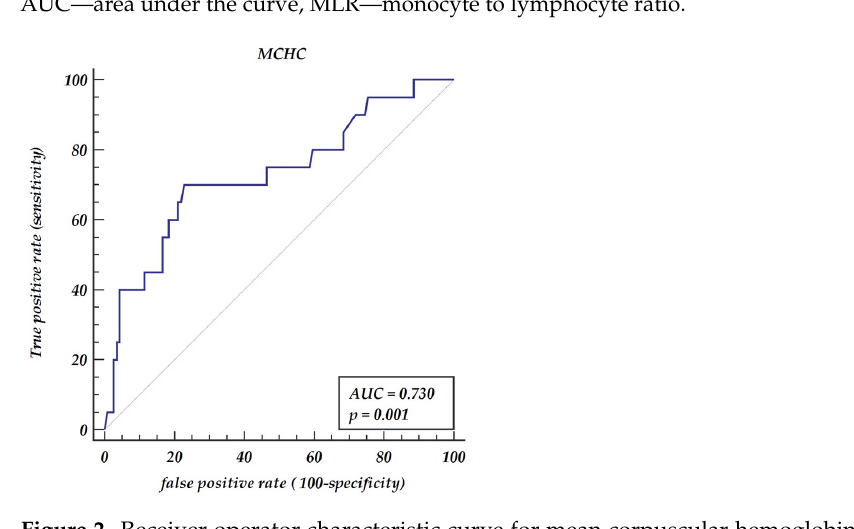
Table 3. Linear regression for collateral carotid disease. Odds